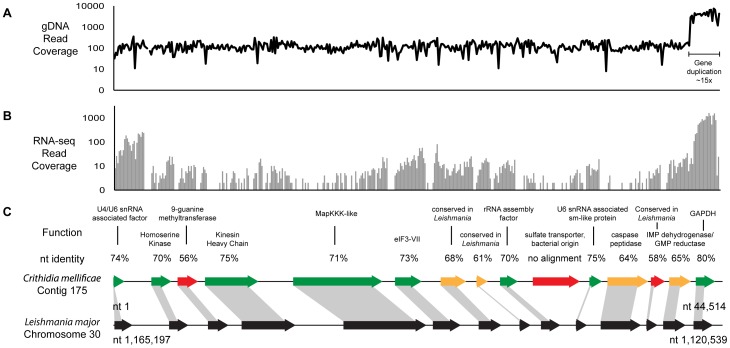
Assembly and annotation of C. mellificae contig 175.(A) Read coverage of the gDNA library used for assembly. A gene duplication of the GAPDH gene is highlighted on the right. (B) RNA-seq coverage aligned to the contig. (C) Genes predicted by the Maker pipeline in C. mellificae with assigned putative functions. The homologous and syntenic region of L. major is shown below, with nucleotide identity of the C. mellificae genes to L. major color-coded by nt identify (green ≥70%, yellow ≥60%, red <60%). A putative bacterial xenolog of a sulfate transporter, sulfate permease JQ247792, is noted (sixth from the right).